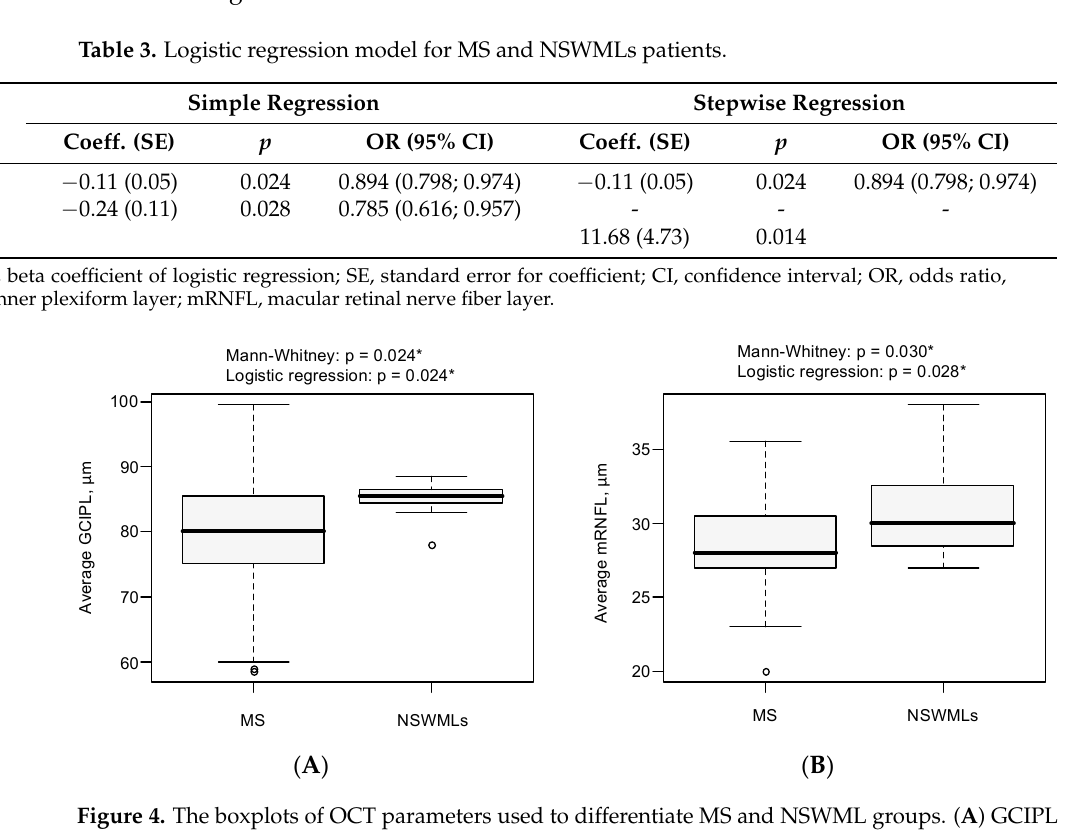
Table 3. Logistic regression model for MS and NSWMLs patients.